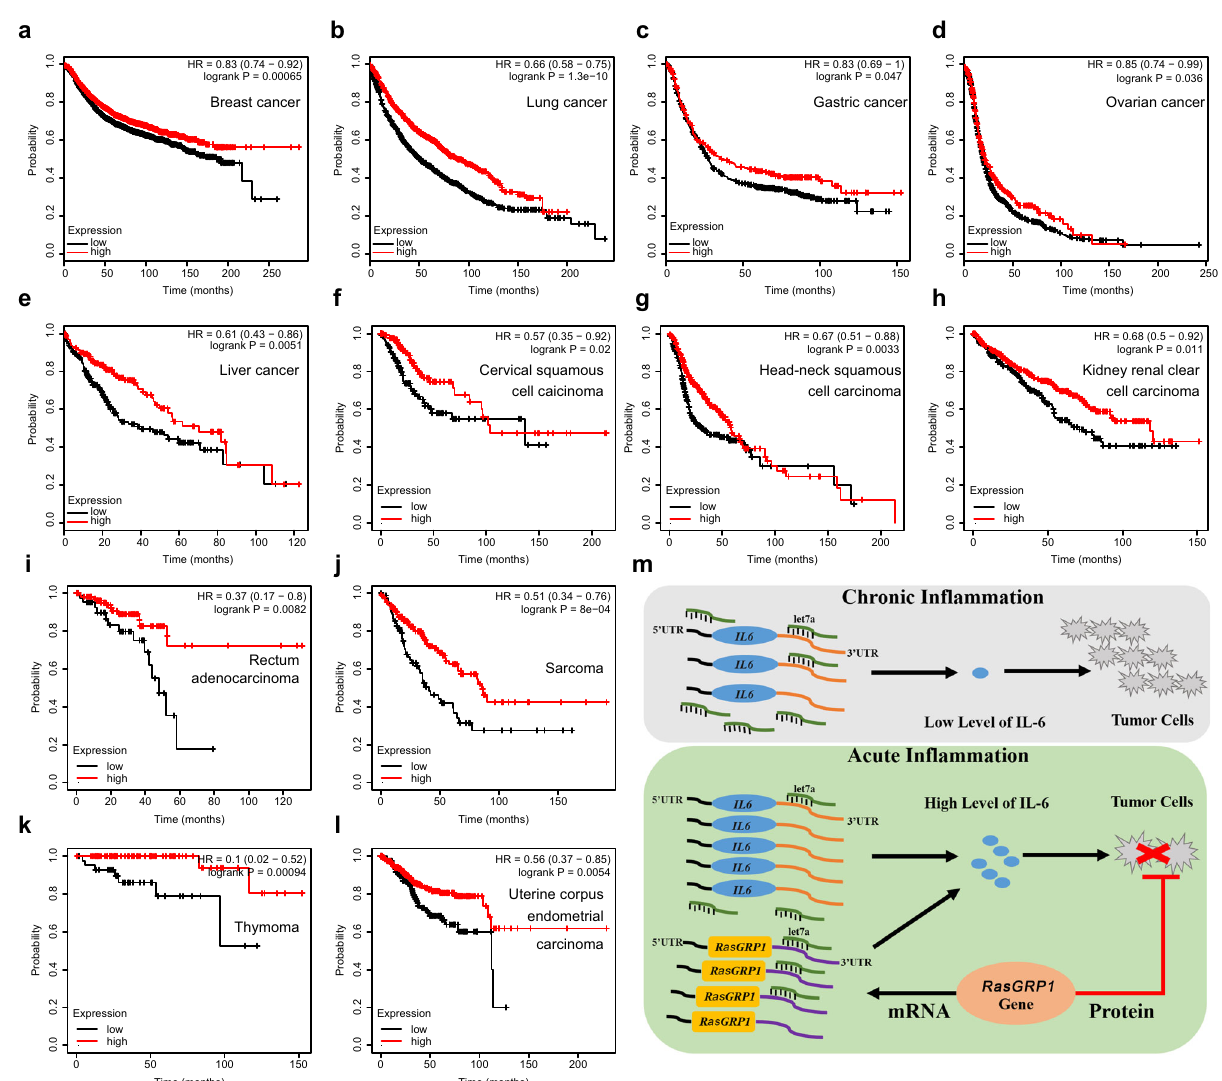
Fig. 8 | RasGRP1 expression correlates with the overall survival of cancer patients. a – l The survival curves determined through Kaplan – Meier plot pro fi ling (http://kmplot.com/analysis/) of cancer patients strati fi ed according to high and low RasGRP1 expression. m Schematic representation showing RasGRP1 effects in